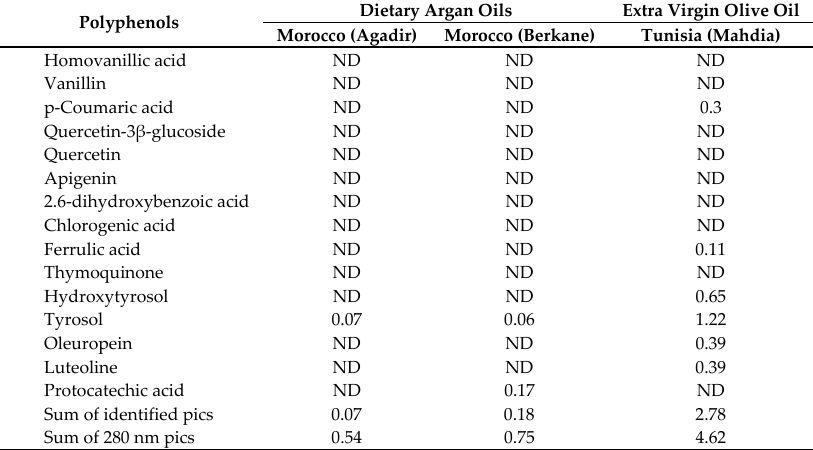
Table 4. Polyphenols content of dietary argan oils (Agadir, Berkane; Morocco) and extra virgin olive oil (Madhia, Tunisia).